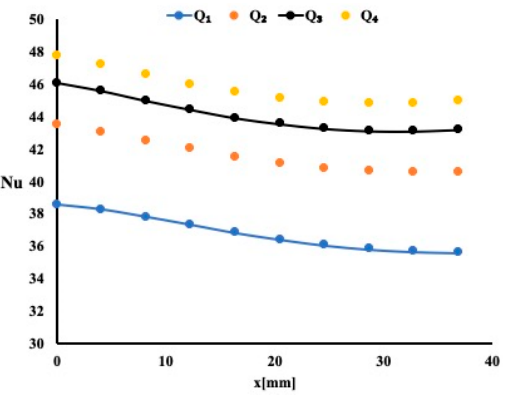
Figure 5. Local Nusselt number variation for a permeability of 20 PPI.